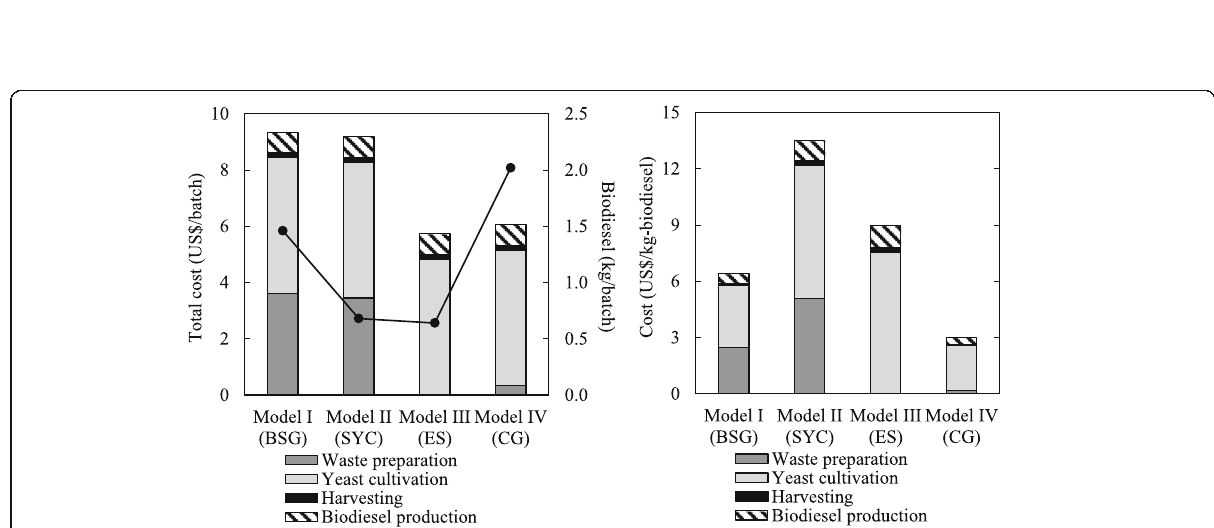
Fig. 4 Comparison of total operating cost and cost per 1 kg-biodiesel of bioconversion of agro-industrial wastes into biodiesel. Symbols with line represent biodiesel